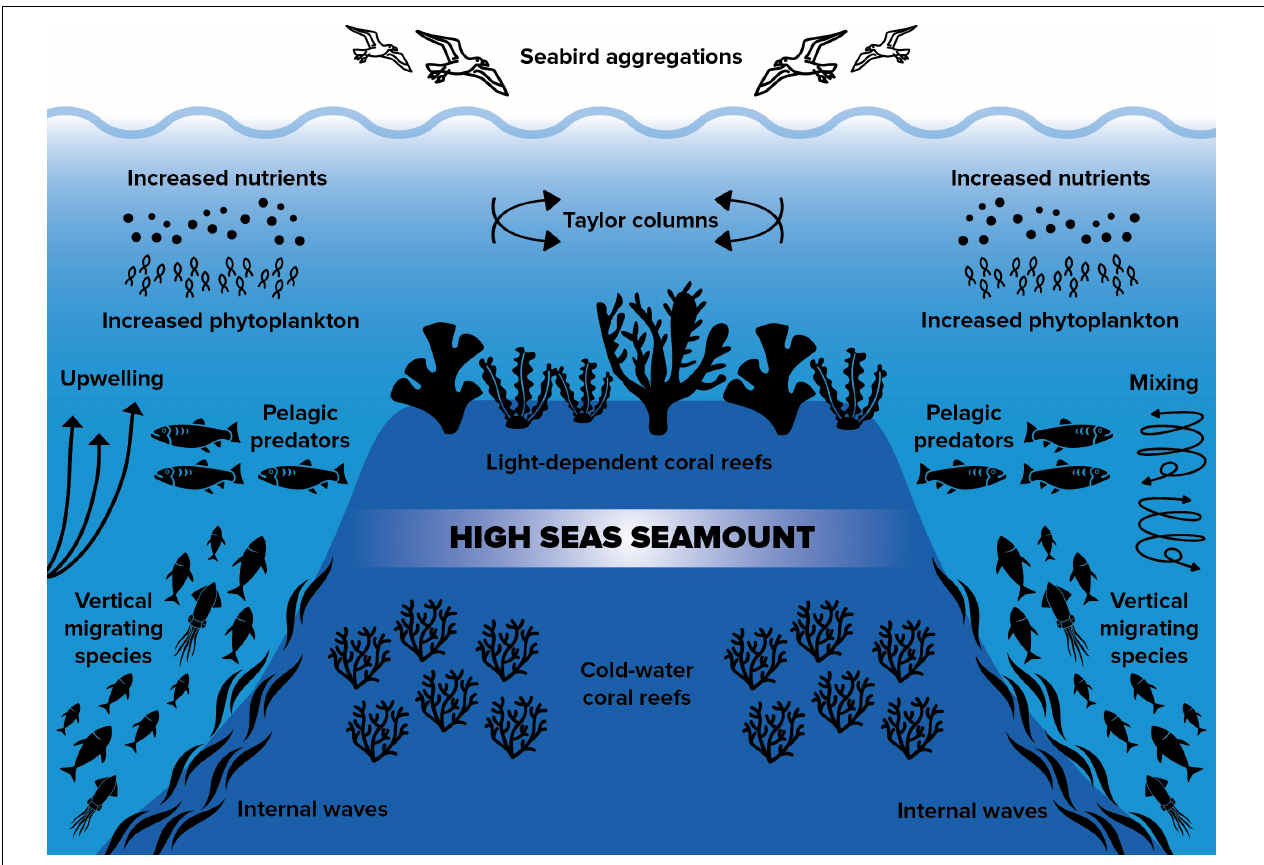
FIGURE 3 | Diagram showing the functional importance of high seas coral reefs, which are associated with seamounts and other steep topographical features in marine areas beyond national jurisdiction. These features create favorable conditions for suspension feeders like corals, and also attract a wide diversity of other